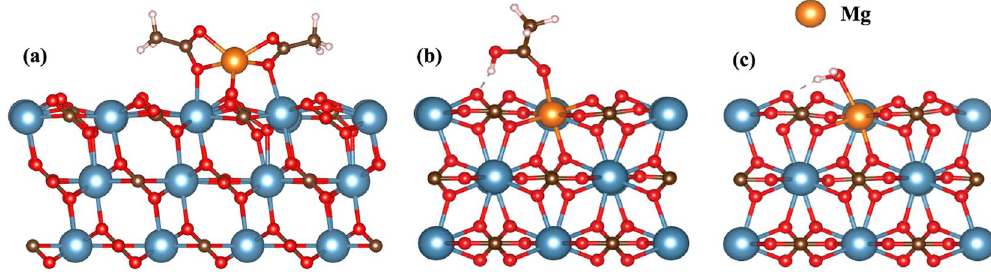
Figure 3. The possible roles of Mg 2 + ions on oil recovery. The atomic structure of Mg acetate on calcite surface